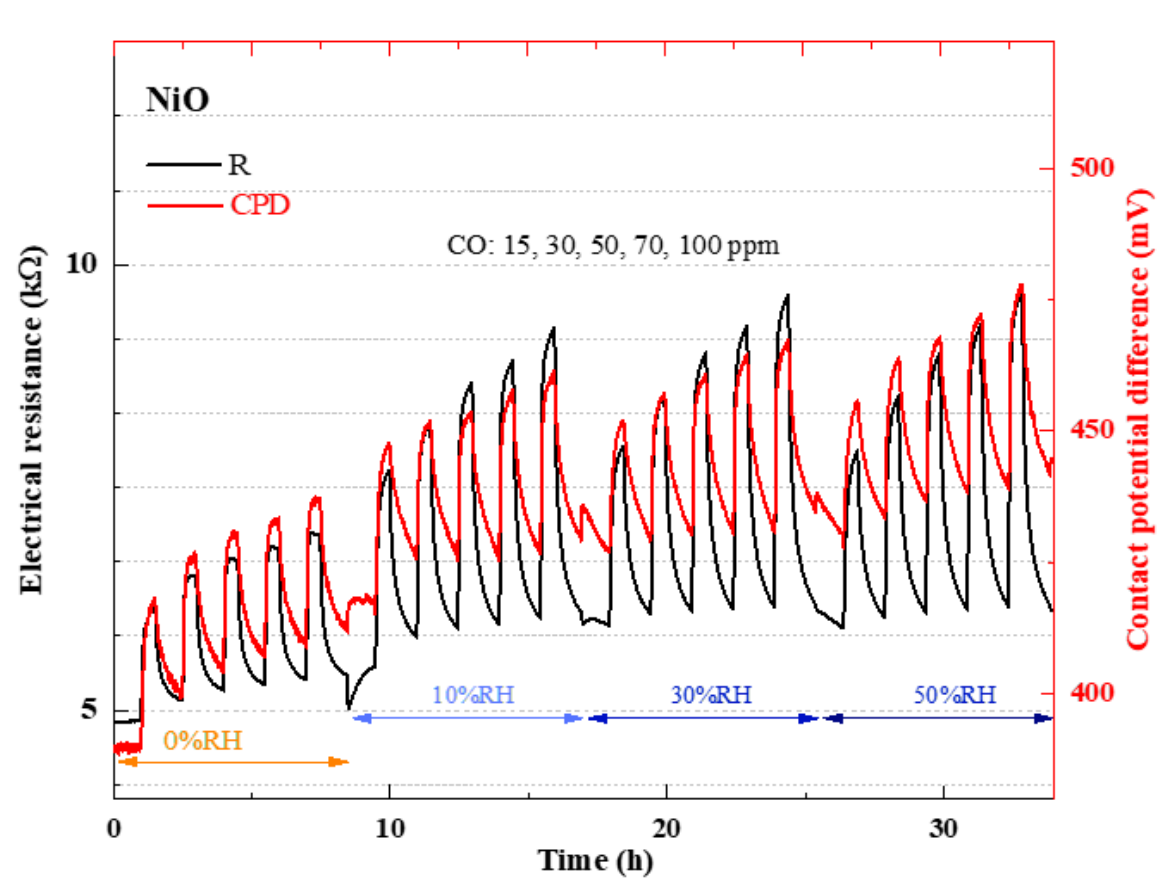
Figure 6. Electrical resistance and contact potential difference with respect to the CO concentration under different RH levels for the NiO sensor operated at 250 ◦